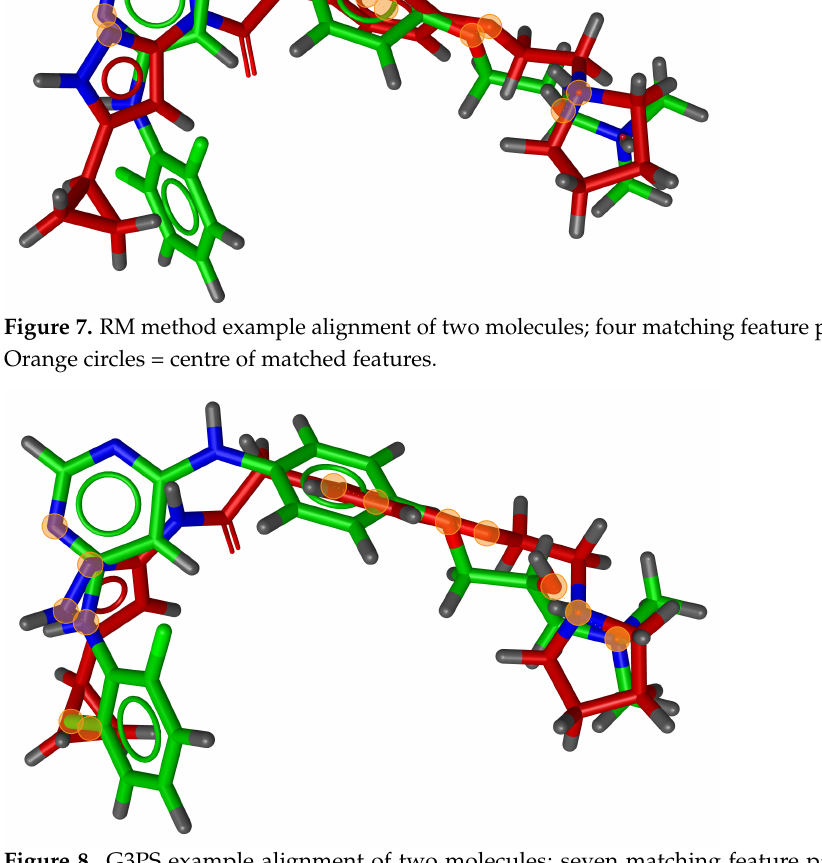
Figure 8. G3PS example alignment of two molecules; seven matching feature pairs were found. Orange circles = centre of matched features.